Question: What direction does the quantity move in — increasing or decreasing?
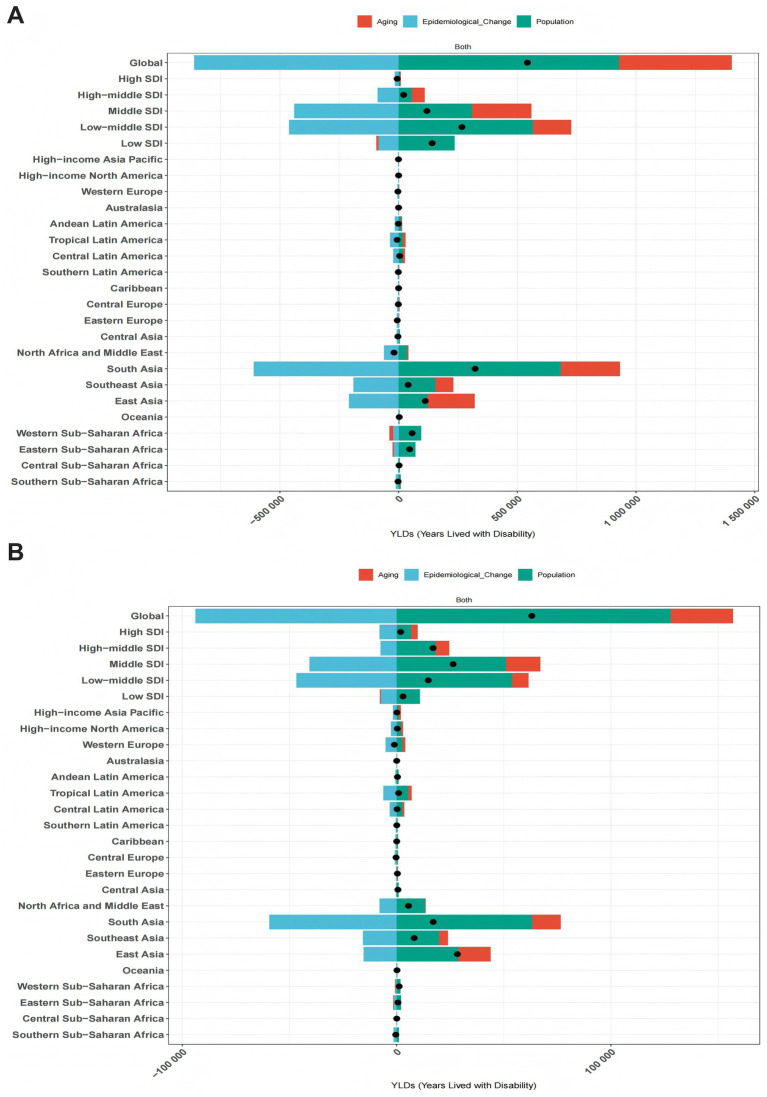
Answer: increasing